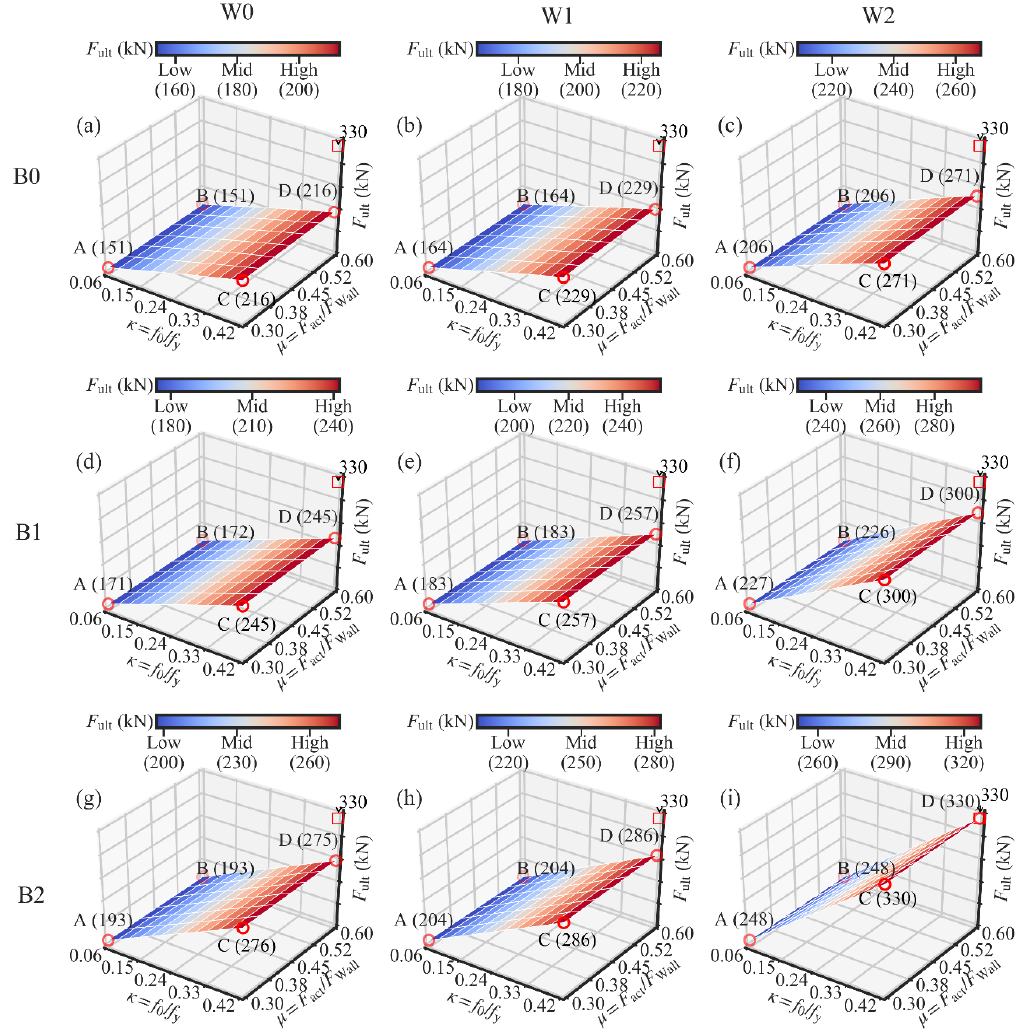
Figure 16. Three-dimensional surfaces of the ultimate strength: ( a ) W0B0; ( b ) W1B0; ( c ) W2B0; ( d ) W0B1; ( e ) W1B1; ( f ) W2B1; ( g ) W0B2; ( h ) W1B2; ( i ) W2B2.